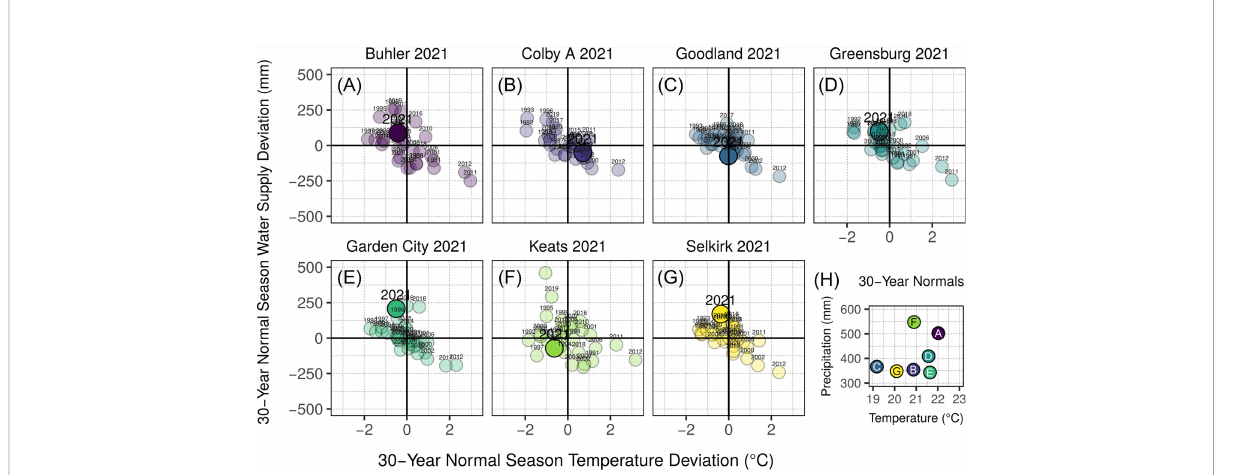
FIGURE 1 Environmental characterization of site-years added to those described previously in Veenstra et al., 2021. Annual season normal precipitation and temperature deviation for 1991-2020 are presented for each site-year (A-G) . Season normal precipitation and temperature characterization by site-year are shown in panel (H) , referring to the panel letter of described site-years. Bold vertical lines in panels A — G indicate normal average temperature for site-year season date ranges, while bold horizontal lines indicate normal precipitation accumulation for site-year season date ranges. Year of study for each site-year (A-G) is indicated with a large, opaque point and enlarged text, and considers both precipitation and irrigation in the water supply value (y-axis). All other years in panels (A-G) are shown with transparent points and smaller text, and water supply (y-axis) includes only precipitation. Base period for all climate normal calculations was